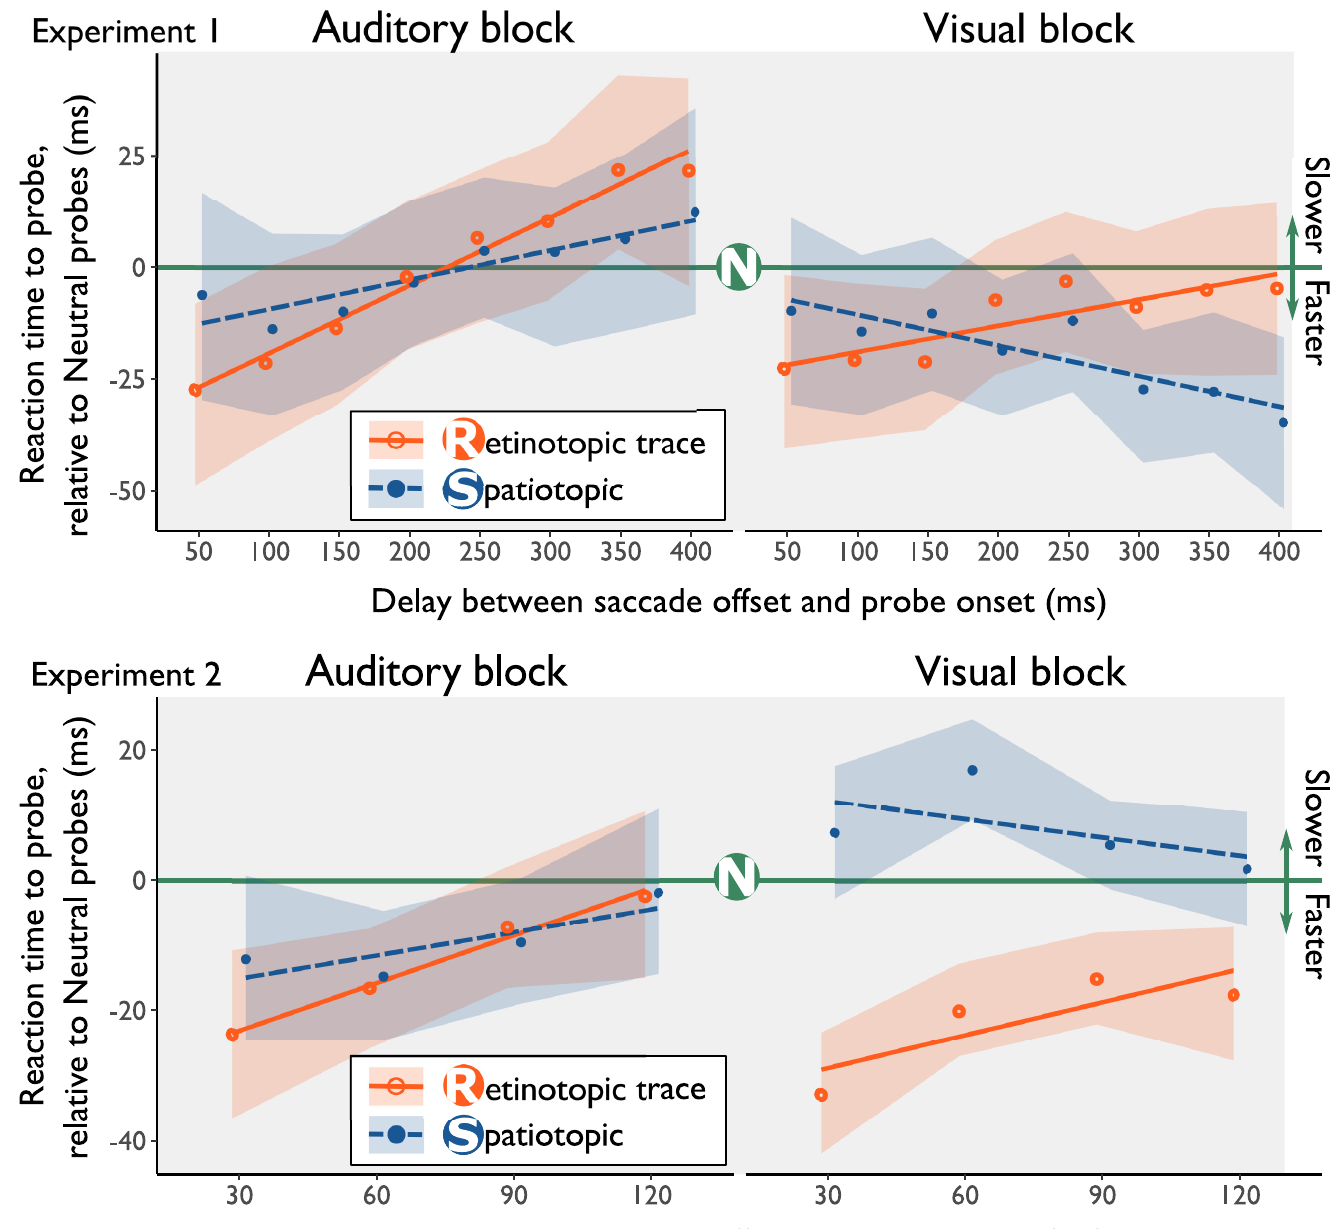
Fig 3. Results from the linear mixed effects models in Experiment 1 and Experiment 2. The green line represents the fit of the linear mixed model of reaction times to probes shown at the neutral location, all other lines are drawn relative to the neutral condition. The lines represented the fits from the linear mixed models, the points indicate the binned average data, after correcting for online saccade detection. In both the visual and auditory experimental block, probes at the location of the retinotopic trace are reacted to significantly faster. This facilitation decreases with longer delays between saccade offset and probe onset, indicating that the retinotopic trace extinguishes over time. Shaded regions represent bootstrapped 95% CI’s. To reduce visual overlap, the orange and blue line have been offset slightly in the horizontal direction.